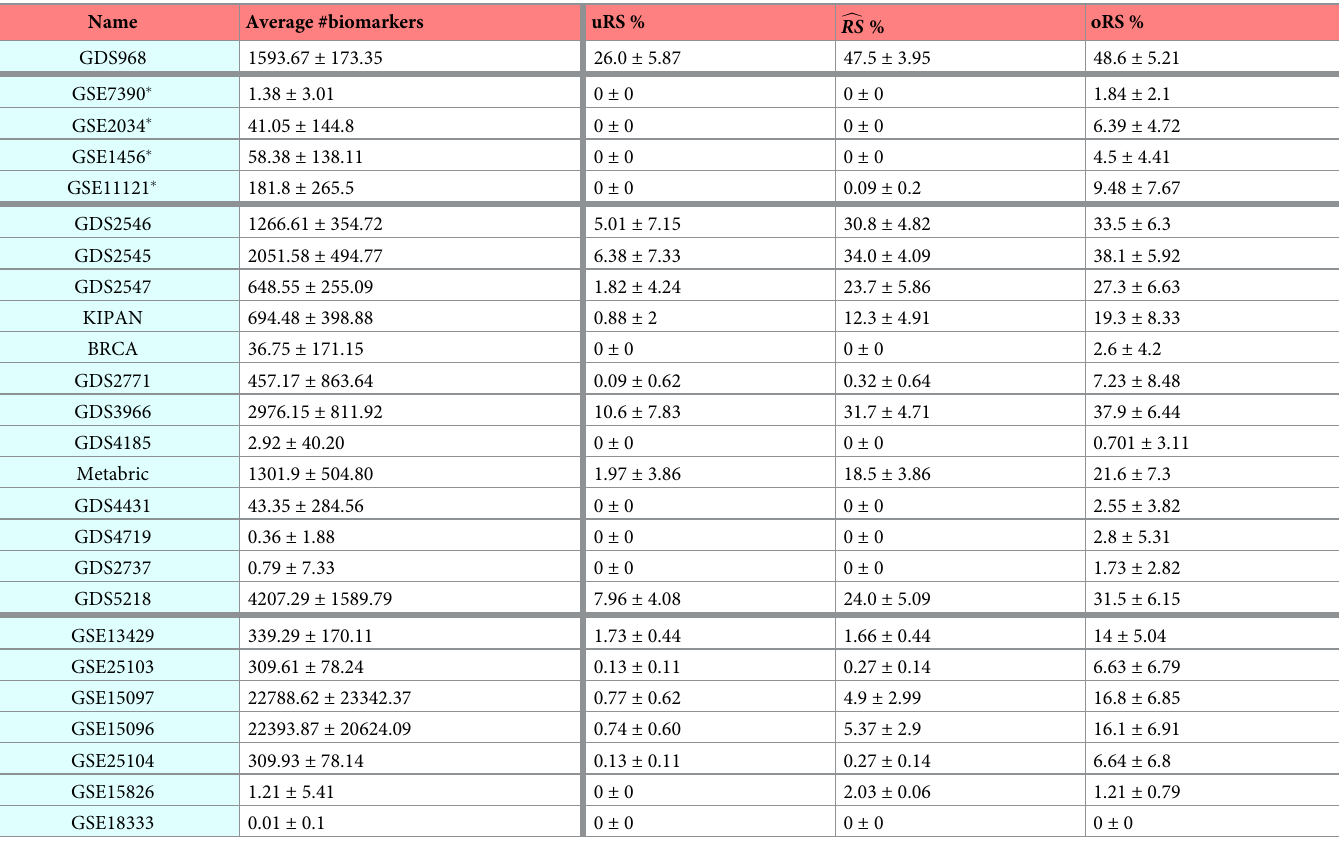
Table 2. Results for all datasets when using half of the subjects– i.e. , D ( n /2) . Reproducibility Scores and average number of biomarkers are shown in the form of mean ± standard deviation. (The caption for Table 1 describes the row